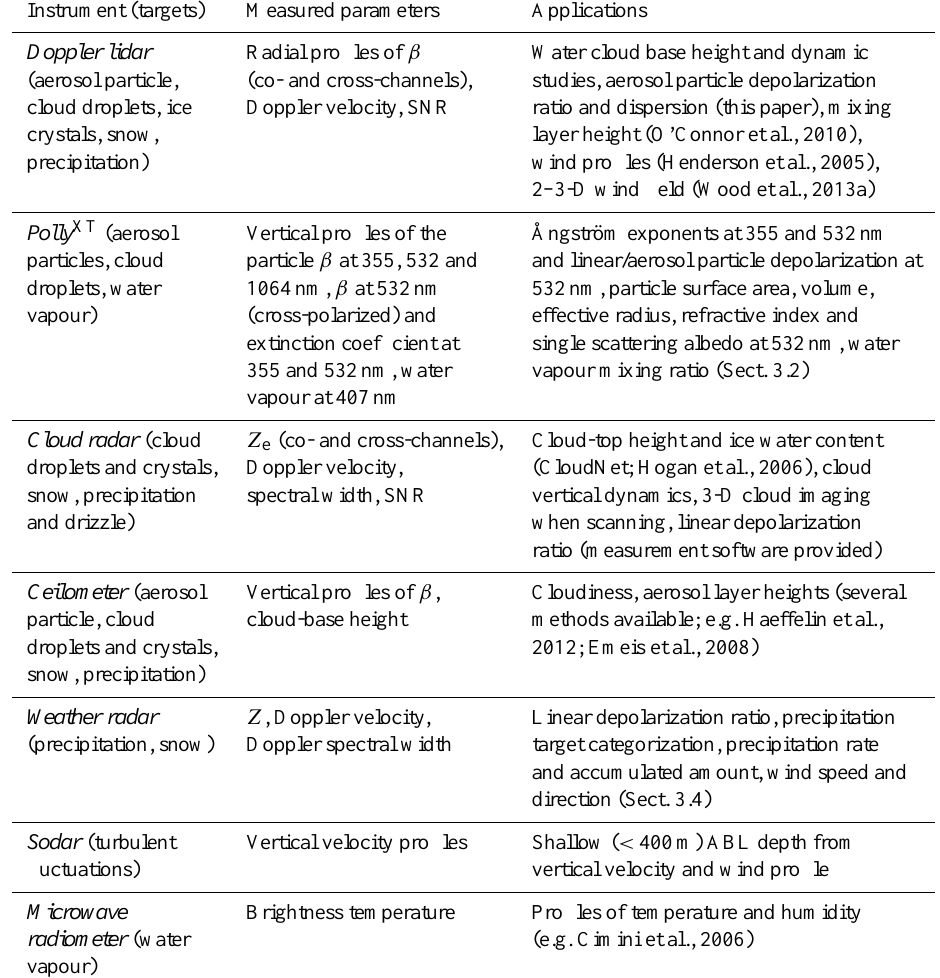
Table 2. Summary of measured quantities and means of application (with example references) of remote-sensing instruments: β and Z e refer to attenuated backscatter coefficient and radar equivalent reflectivity factor,